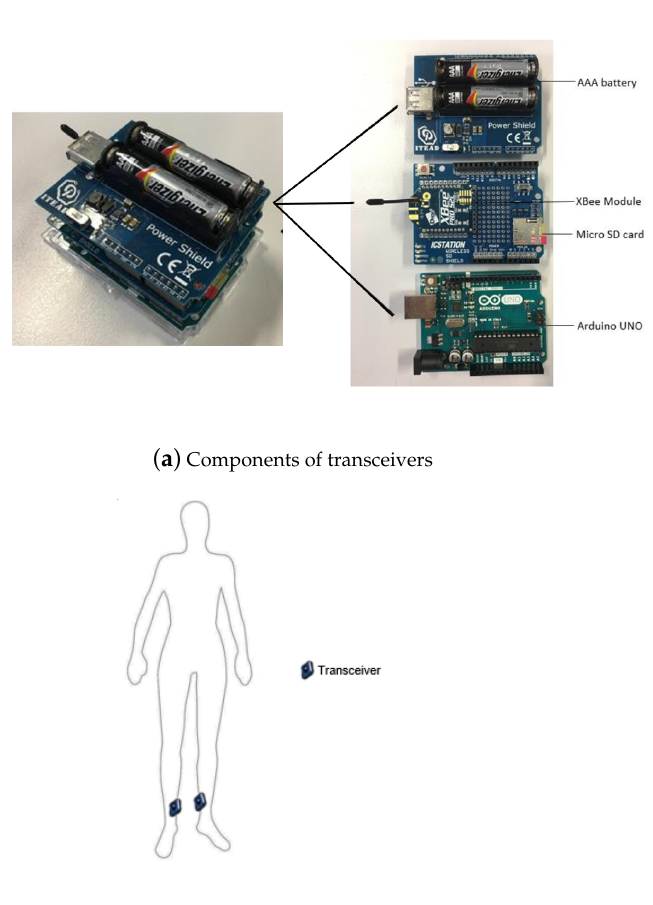
Figure 1. Hardware